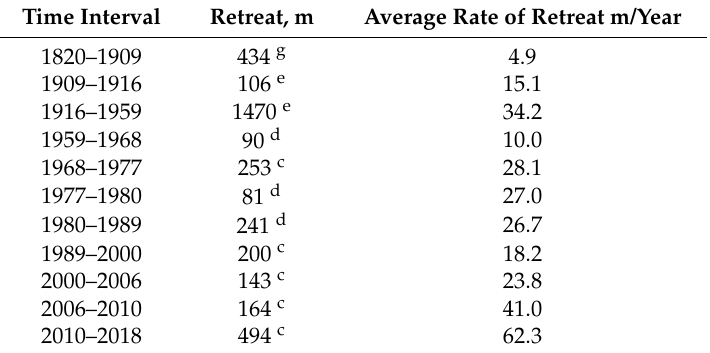
Table 6. Rates of retreat of Kanas (Halasi, Przewalski, No. 46, Figure 13) glacier. Time Interval Retreat, m Average Rate of Retreat m/Year 1820–1909 434